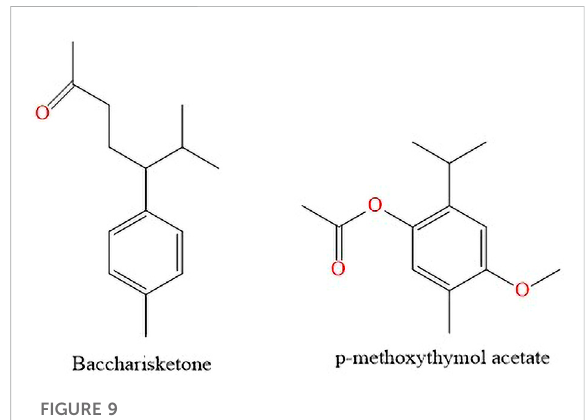
FIGURE 9 Monoterpenes found in B. dracunculifolia leaves